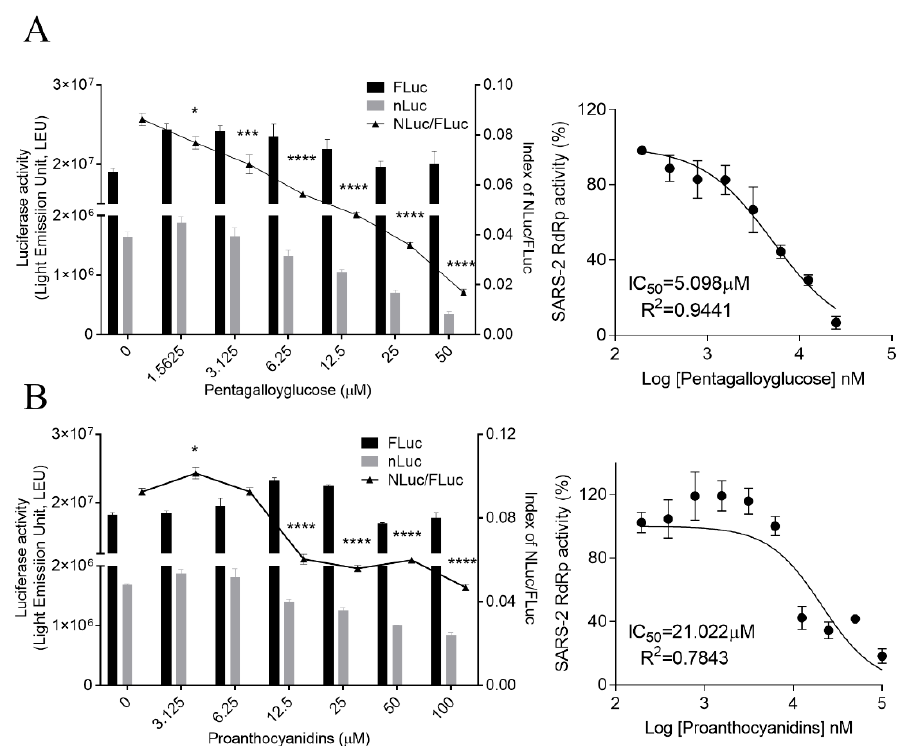
Figure 4. Inhibitory effect of PGG and PAC on the SARS-CoV-2 RdRp activity in the cell-based reporter assay system. A reporter plasmid, p(+)FLuc-( − )UTR-NLuc, and an RdRp expression plasmid, pCI-SARS2-nsp12N, were transfected in HEK293T cells. The cells were treated with serially diluted-PGG ( A ) and PAC ( B ) 6h later. After an 18 h incubation, the expression levels of FLuc and NLuc (left Y axis) were detected, and the NLuc/FLuc ratios (right Y axis) were calculated (left panel). Statistical comparisons were conducted using one-way analysis of variance (ANOVA), followed by Bonferroni’s multiple comparison test. * p < 0.05; *** p < 0.001; **** p < 0.0001 vs. 0 μ M (left graph). The IC 50 values were determined using nonlinear regression analysis (right graph). The data are representative of three independent experiments, and presented as mean ±